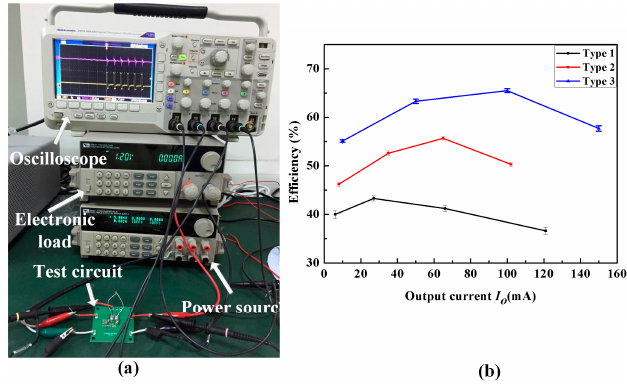
Figure 12. ( a ) Testing setup; ( b ) Efficiency versus output current of the DC/DC buck converter using fabricated micro-inductors.